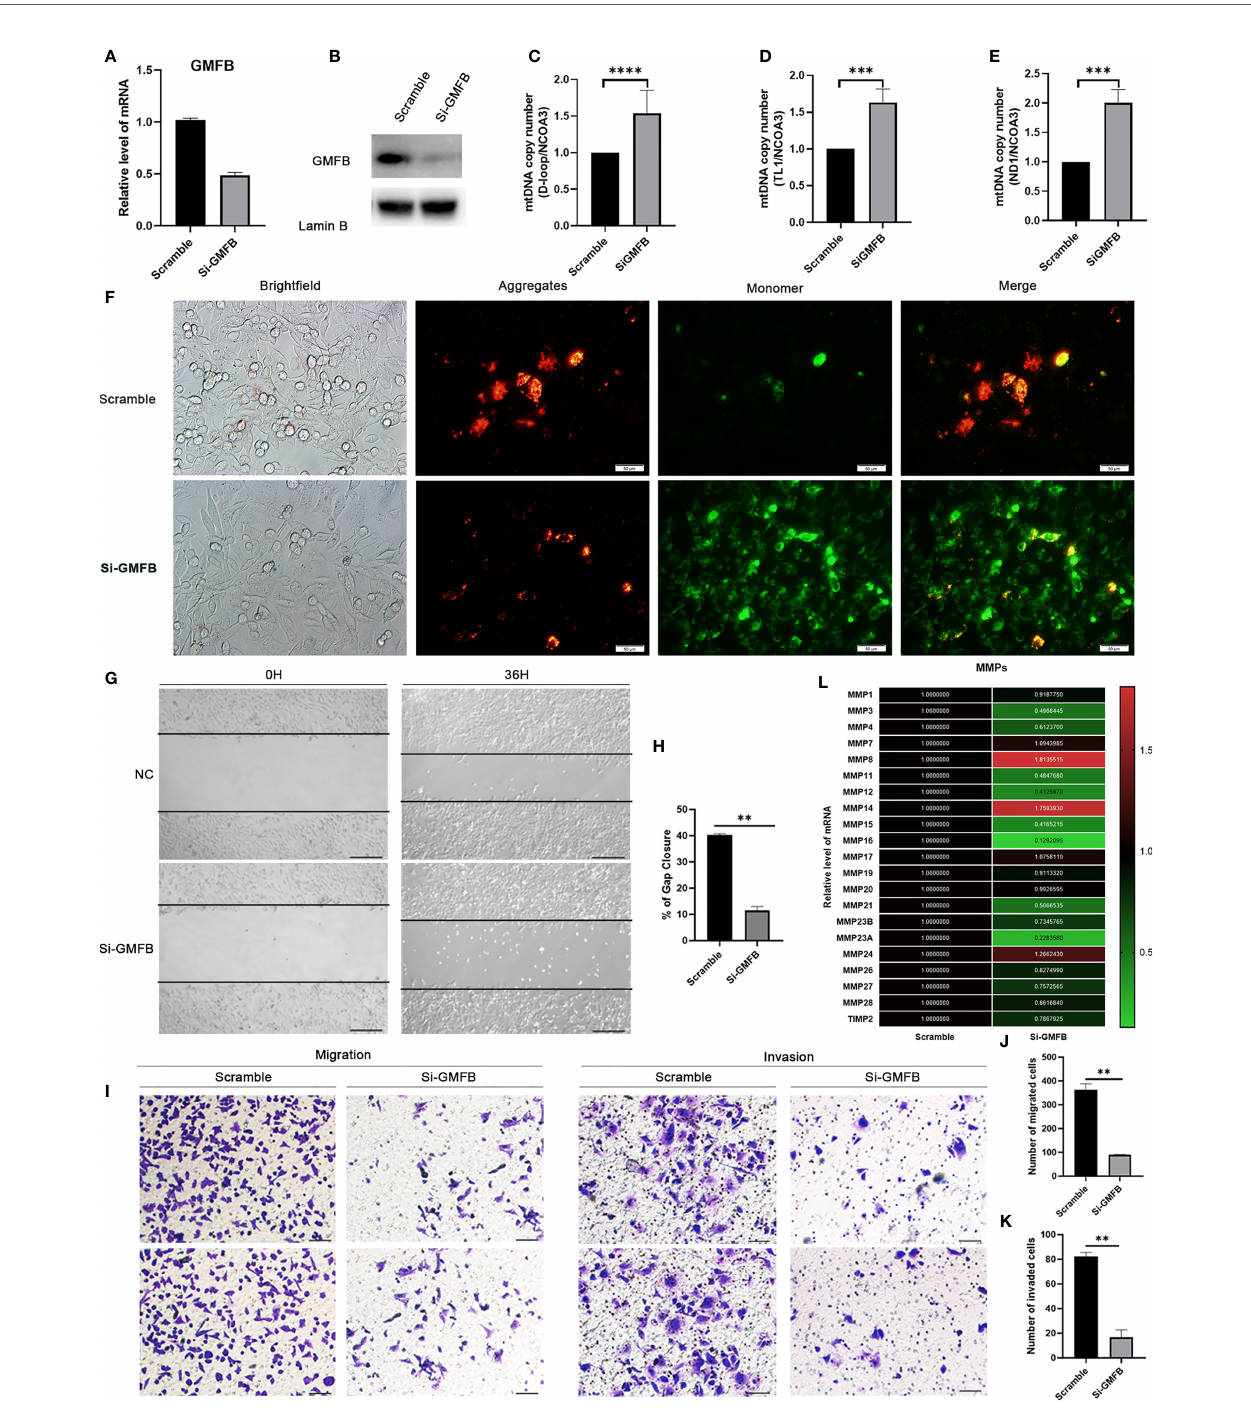
FIGURE 7 | Knock down GMFB decreased mtDNA copy number and inhibits proliferation and invasion of Hep3B cell. (A) SiRNA ef fi ciently knock down GMFB mRNA levels by qRT-PCR in Hep3B cells. (B) SiRNA ef fi ciently knock down GMFB protein levels by western blot in Hep3B cells. (C – E) Relative mtDNA copy number (mtDNA/nDNA) was detected by qPCR and normalized by nuclear receptor coactivator 3(NCOA3) gene in knockdown GMFB. GMFB knockdown. (F) Fluorescence microscopic imaging of Hep3B cells stained with JC-1. Scale bar, 50 m m. (G) Image of the scratch assay. Scale bar, 100 m m. (H) Quanti fi cation of the scratch assay. Error bars represent standard error of means (SEM). (I) Transwell migration and invasion assays were used to examine the migration and invasion ability of HCC cells. Scale bar, 100 m m. Quanti fi cation of migration (J) and invasion assays (K) . Error bars represent standard error of means (SEM). (L) Heat map of relative qPCR results of MMPs. **P < 0.01, ***P < 0.001, ****P <